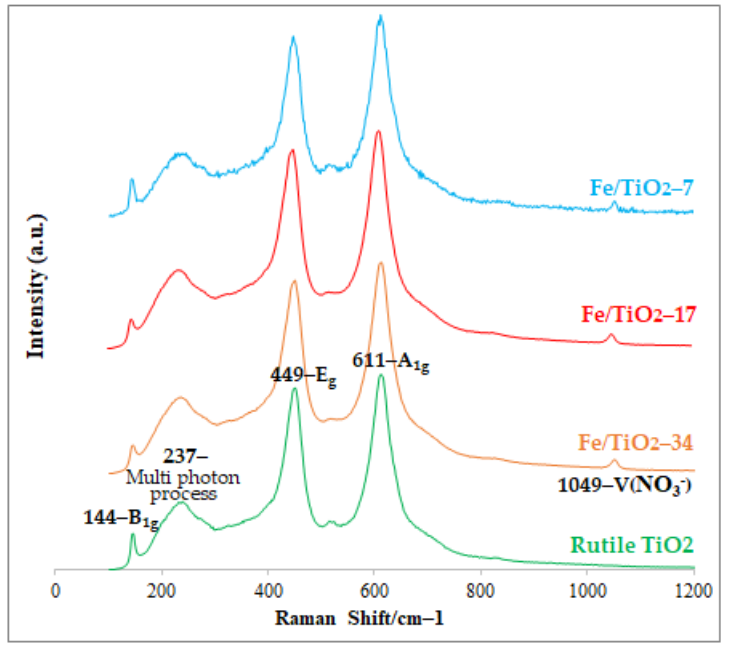
Figure 3. Micro-Raman spectra of the rutile TiO 2 (Rutile), ball-milled TiO 2 (Rutile-7), and Fe/TiO 2 (B/P = 7, 17, and 34) prepared by mechanochemical ball-milling at 400 rpm for 10 h.